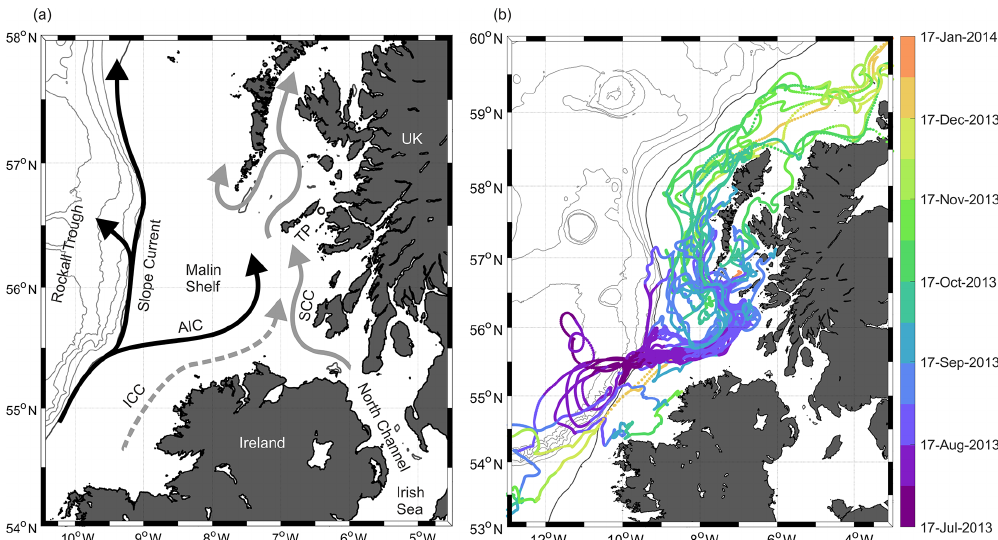
Figure 1. (a) Schematic of study regions showing the features mentioned in text. Oceanic water pathways are shown in black, and coastal water pathways are shown in grey. The solid grey line shows the Scottish Coastal Current (SCC), and the dashed grey line indicates the pathway of the Irish Coastal Current (ICC, summer only). AIC: Atlantic Inflow Current, TP: Tiree Passage. The location of the Tiree Passage Mooring is indicated by the black circle. (b) Trajectories of drifters released during the FASTNEt JC88 cruise (drogued at 15 and 70m), coloured by date. Bathymetry contours from GEBCO bathymetry (http://www.gebco.net/, last access: 24 July 2017). GEBCO: General Bathymetry Chart of the